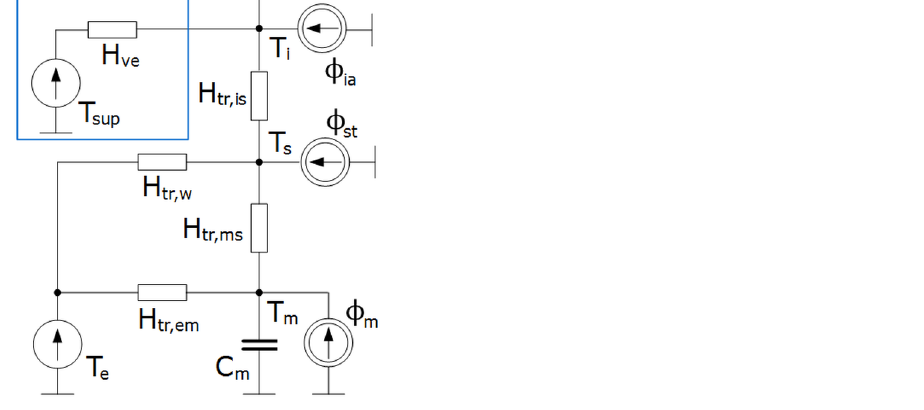
Figure 1. The 5R1C thermal network model of a building zone from EN ISO 13790.